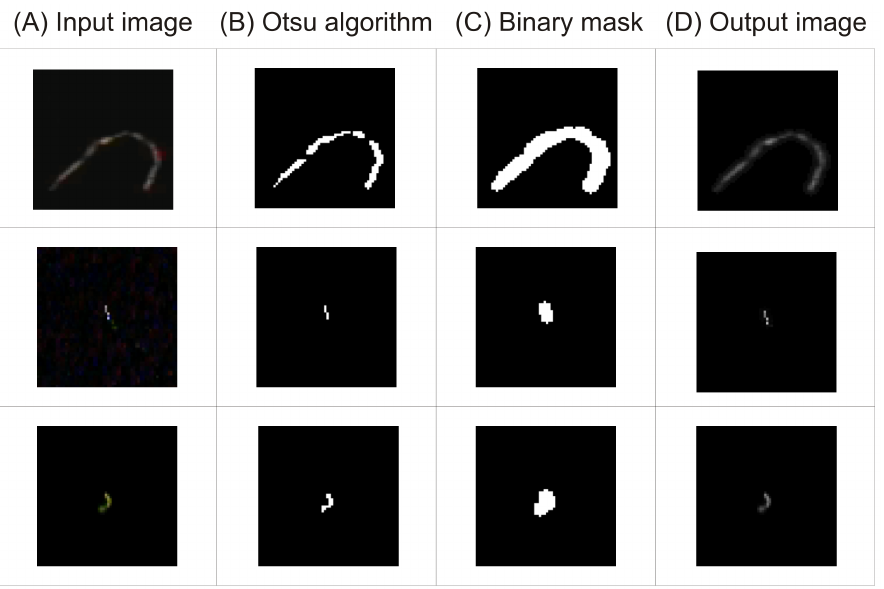
Figure 3. Image preprocessing pipeline. Each row represents a separate image. Each column showsthe final result of a single preprocessing transformation performed on the image. The fol- lowingprocessing steps are included: input image loading with conversion to grayscale format ( A ), automaticthresholding via the Otsu algorithm ( B ), creation of a binary mask ( C ), and definitive filteringoverlaying the binary mask on the grayscale image ( D